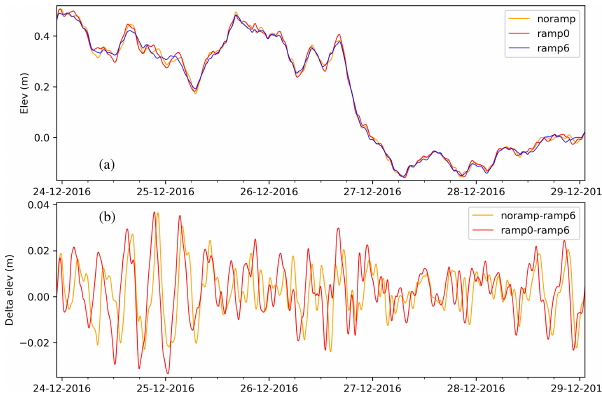
Figure 11. NA3 surge elevation at Wick station during Decem- ber 2016 forced by ECMWF-IFS data. (a) Results for models forced by the “noramp” (discontinuous), “ramp0”, and “ramp6” methods and (b) differences between short ramps and the recommended